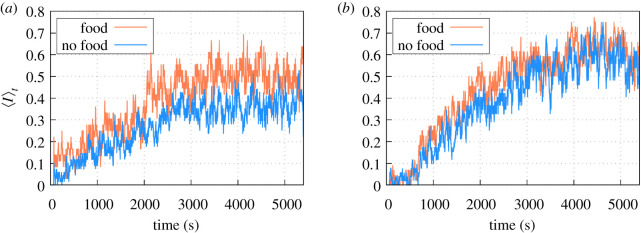
Averaged daily occupancy 〈I〉t for those nodes where food is present (red) or not (blue), for (a) regime A and (b) regime B. Comparison of stationary (2700–5400 s period) values leads to (⟨I⟩t f=0.50 and ⟨I⟩tnf=0.34) for the case in (a), showing significant departures, while for case in (b) we find (⟨I⟩t f=0.60 and ⟨I⟩tnf=0.55), much less difference is obtained.